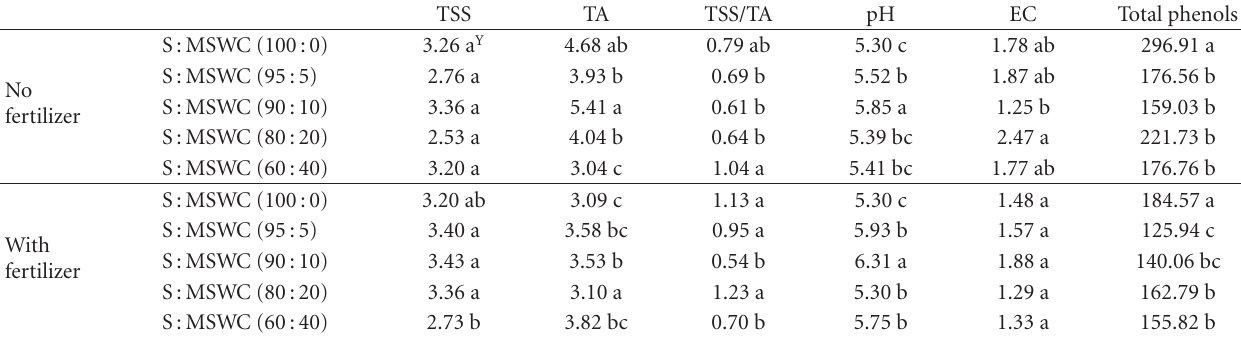
Table 4: E ff ects of municipal solid waste compost (MSWC) into soil (S) with or without fertigation on total soluble solids (TSS: ◦ Brix), titratable acidity (TA: (% citric acid), sweetness (TSS/TA), Ph, EC (mS/cm), and total phenols (gallic acid equivalent: GAE/100gfwt)) in greenhouse pepper